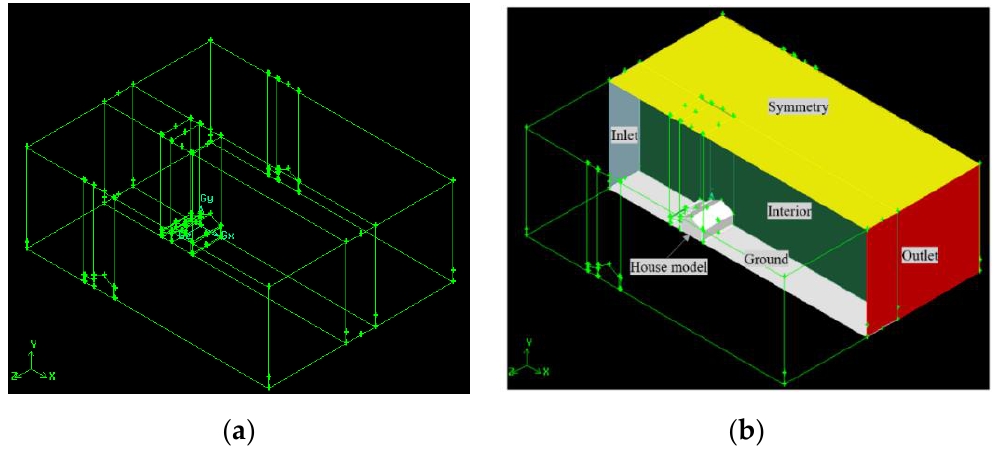
Figure 7. ( a ) Computational domain and ( b ) boundary conditions of the rural house model.